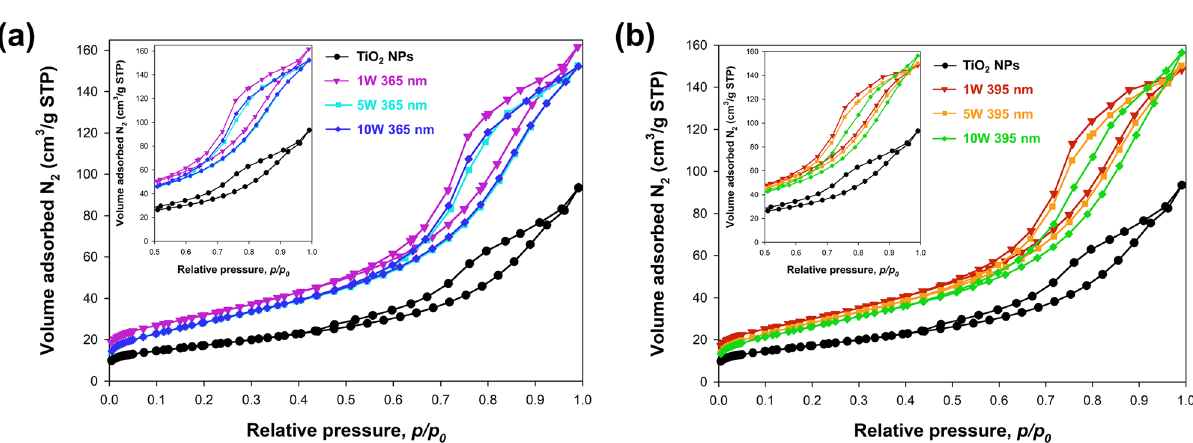
Figure 4. The adsorption–desorption N 2 isotherm for samples series: ( a ) 365 nm and ( b ) 395